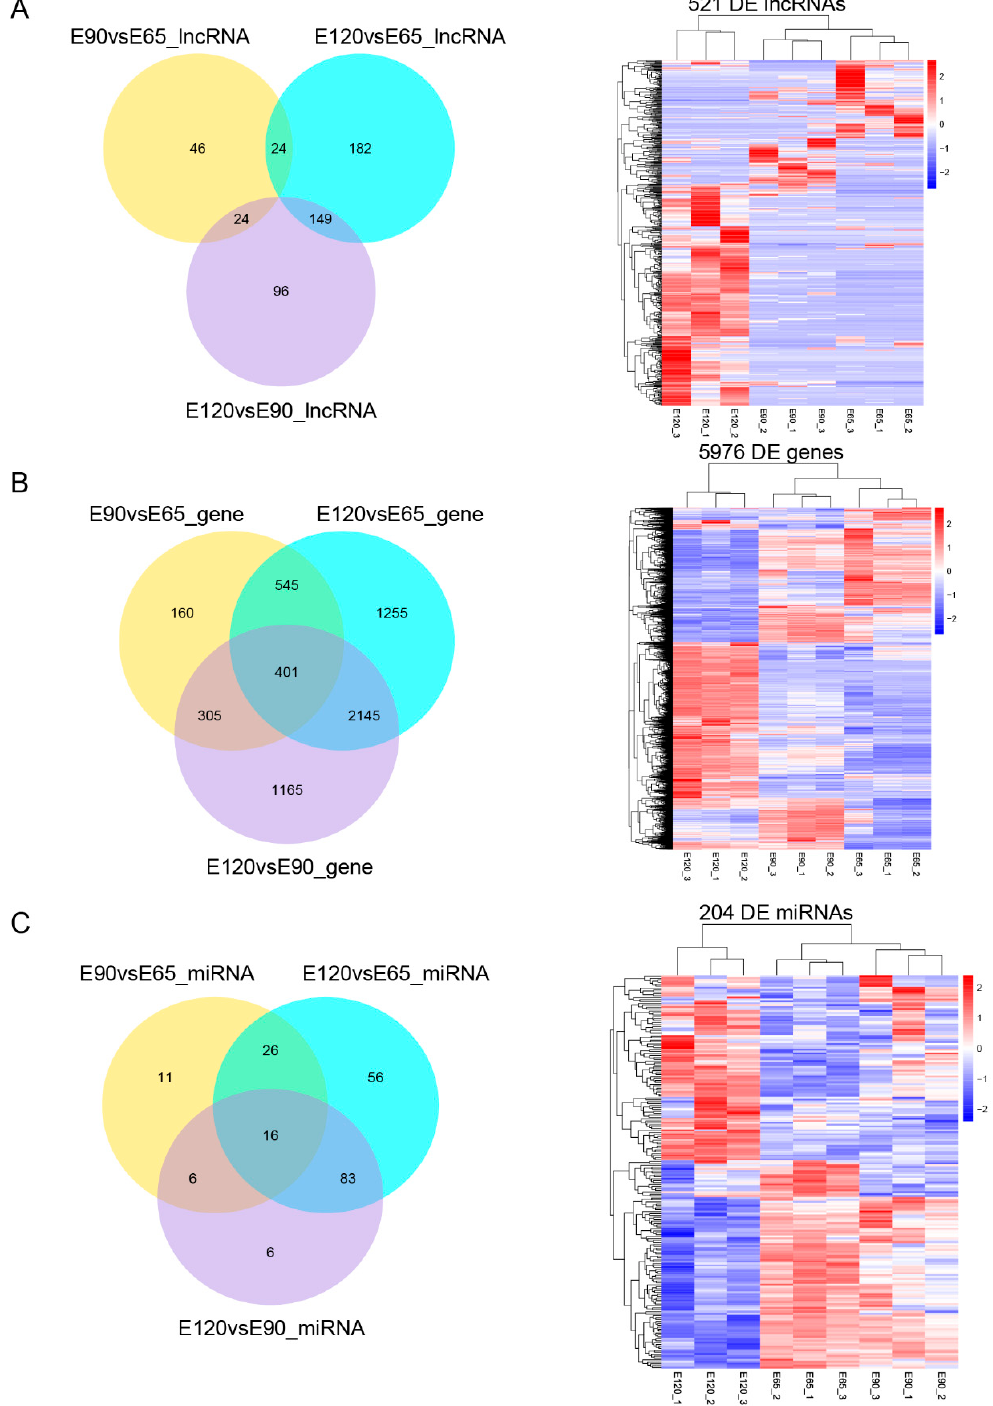
Figure 1. The differentially expressed lncRNAs and genes between E65, E90, and E120 in skin. ( A ) The Venn diagram and heat-map of the differentially expressed lncRNAs. ( B ) The Venn diagram and heat-map of the differentially expressed genes. ( C ) The Venn diagram and heat-map of the dif- ferentially expressed miRNAs.